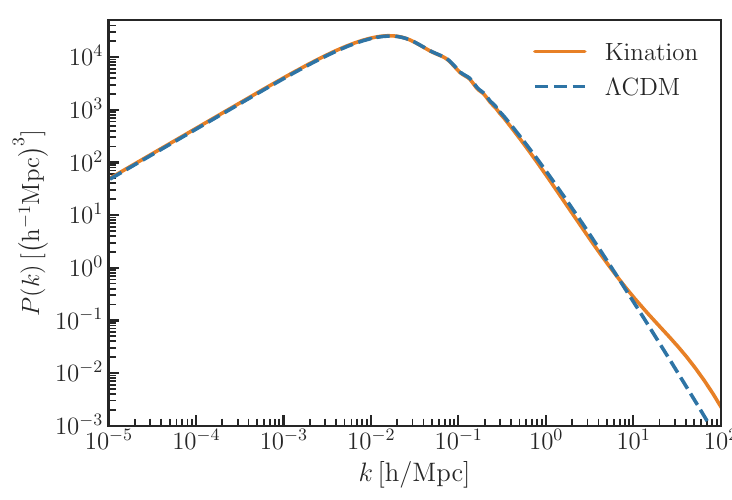
Figure 4 . The linear matter power spectrum for Λ CDM and kination cosmology at z = 0 . For kination cosmology we use T KR = 50 eV and T RM = 5 keV . Kination leads to an enhanced linear power spectrum above k ≈ O (1) h / Mpc